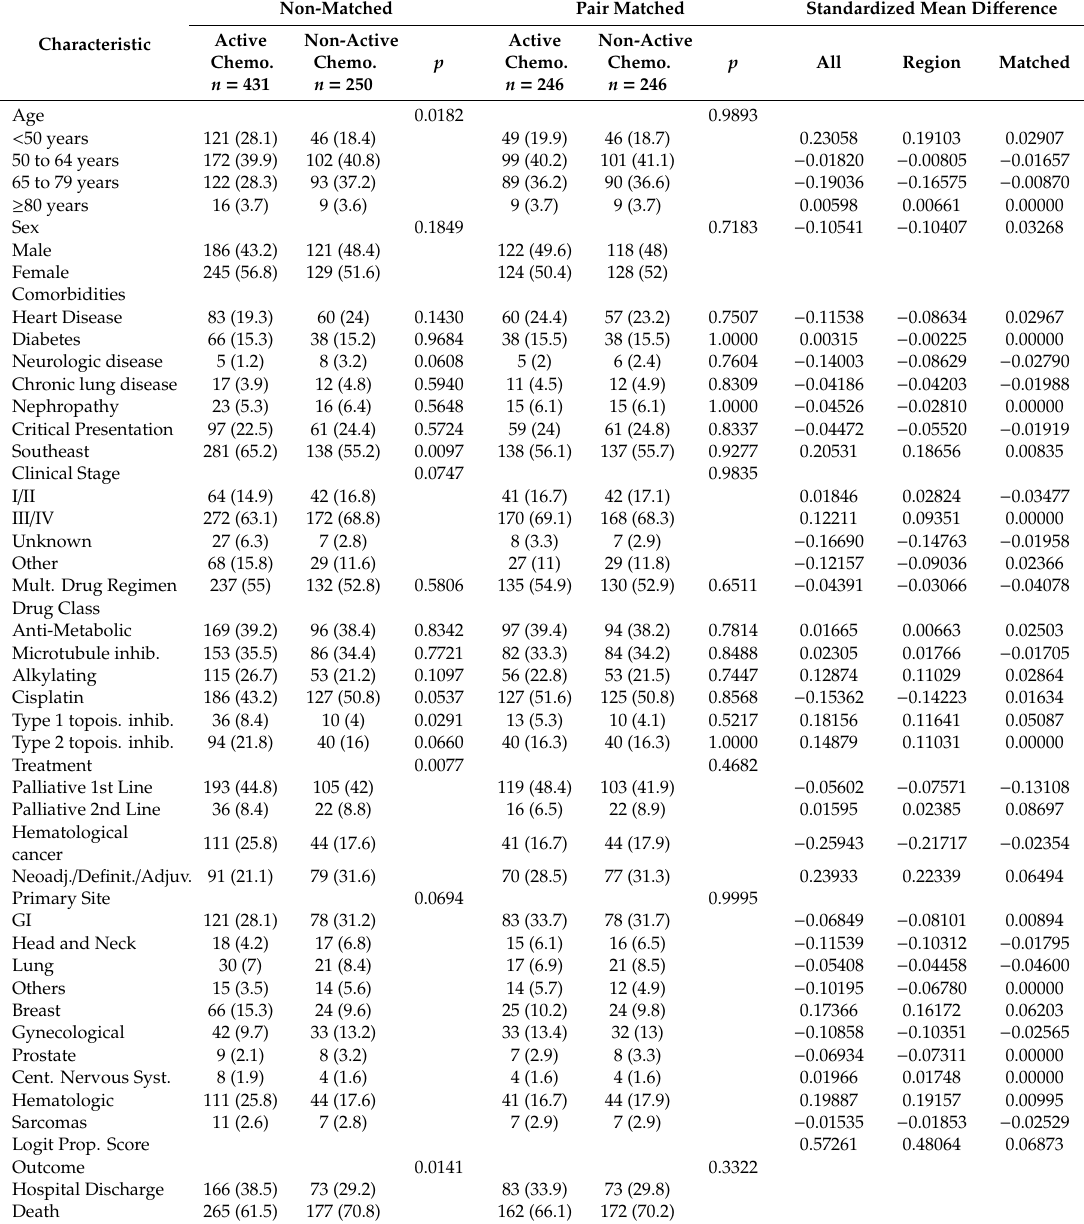
Table 1. Baseline variables before and after active and non-active chemotherapy groups propensity score